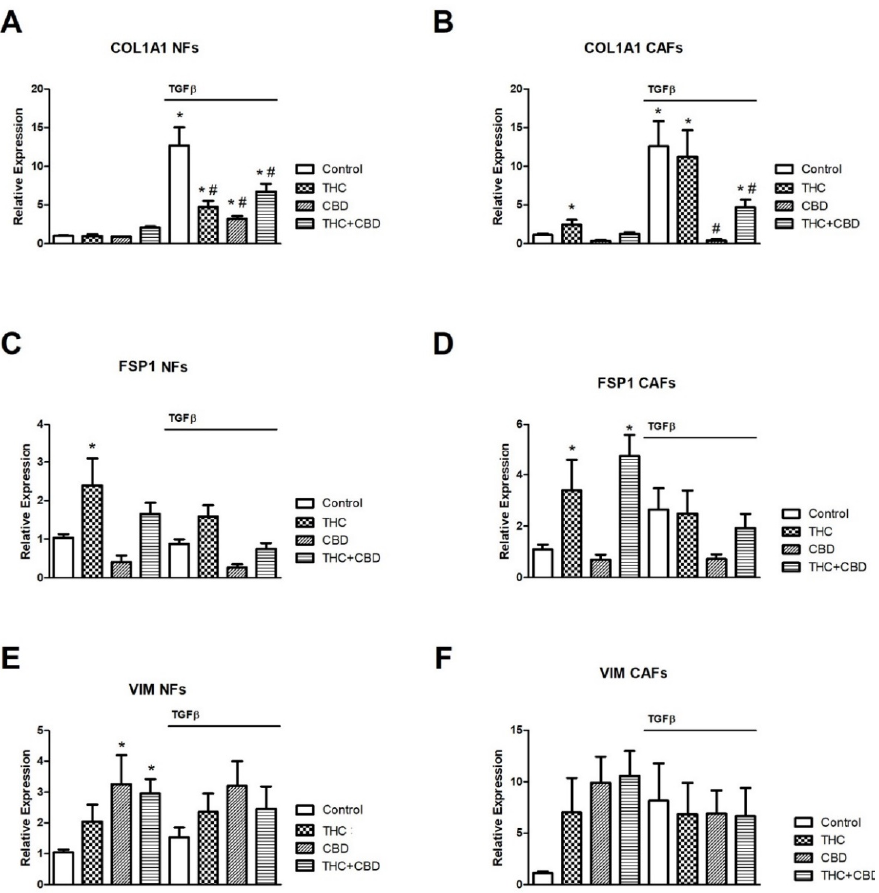
Figure 2. Effect of cannabinoid agonists on fibroblast-related gene expression. NFs ( A , C , E ) and CAFs ( B , D , F ) were cultured for 72 h in the presence or absence of 5 ng/mL TGF β and treated or not with 30 µ M THC, 30 µ M CBD, or an equimolar mixture of 10 µ M THC + CBD. The relative gene expression of COL1A1, FSP1 and VIM was studied by real-time RT-PCR using GAPDH as housekeeping. Average fold change ± SD of 3 different experiments is represented. A triplicate was analyzed in each of the experiments. * p < 0.05 compared to the control group not stimulated with TGF β . # p < 0.05 compared to the TGF β -stimulated control